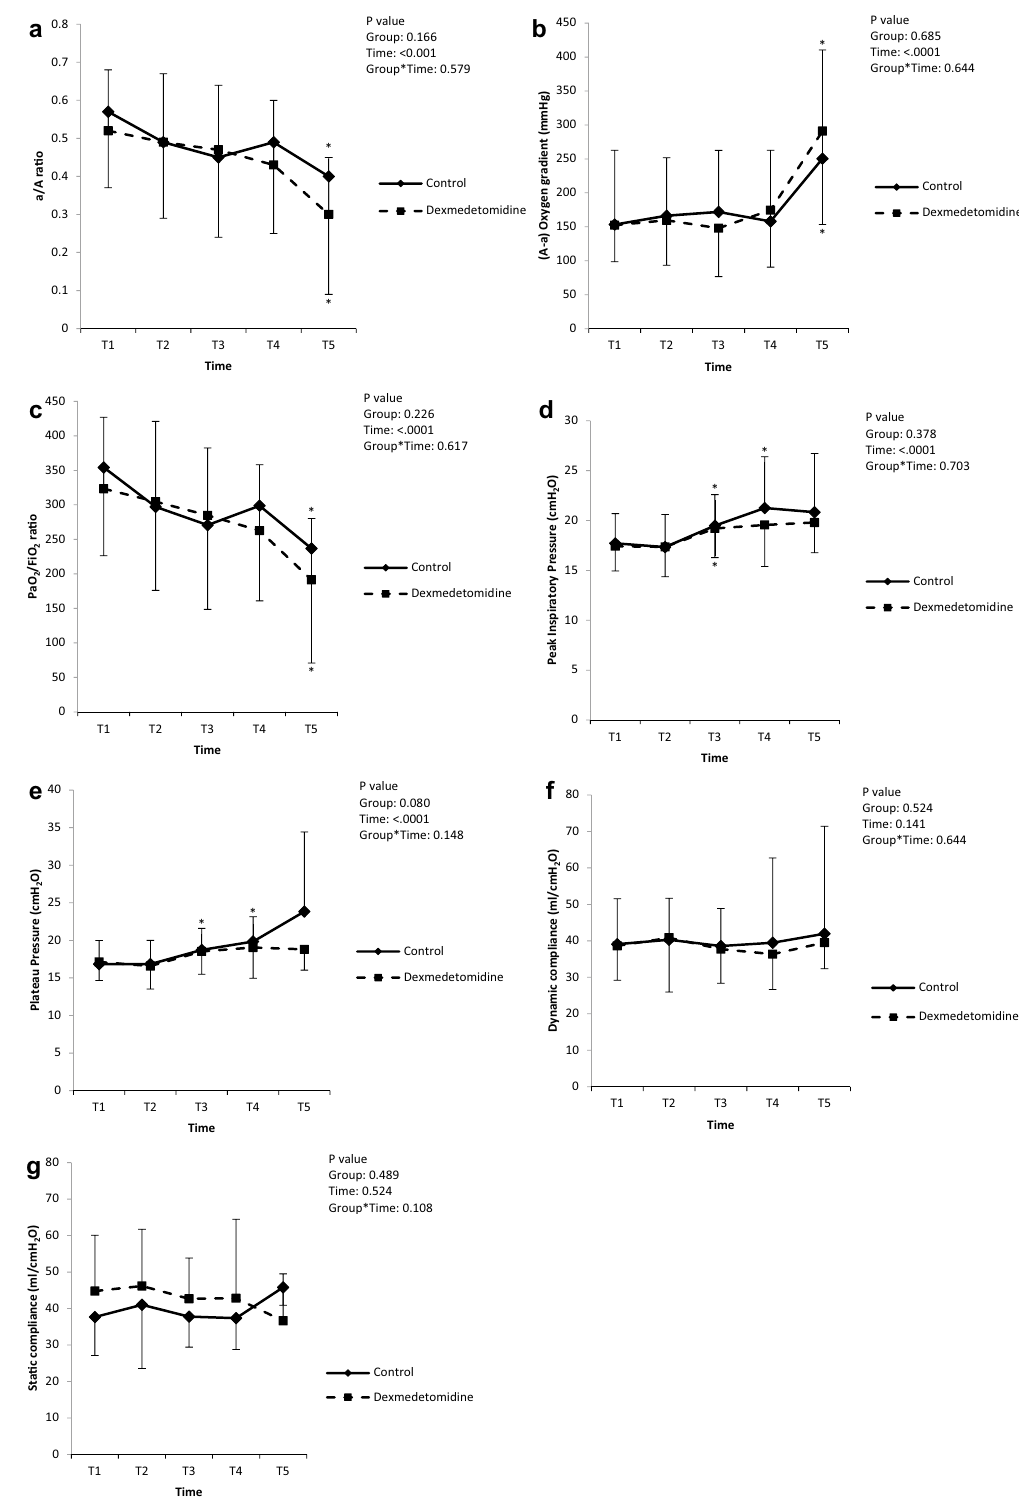
Figure 2. Changes in the lung function indices. a/A, arterial O 2 partial pressure to alveolar O 2 partial pressure ratio; A–a, alveolar-arterial; PaO 2 , partial pressure of oxygen; FiO 2 , fraction of inspired oxygen; T1, post- induction; T2, ACC 1 h; T3, ACC 6 h; T4, ACC 12 h; T5, ACC 24 h. * P < 0.05 versus